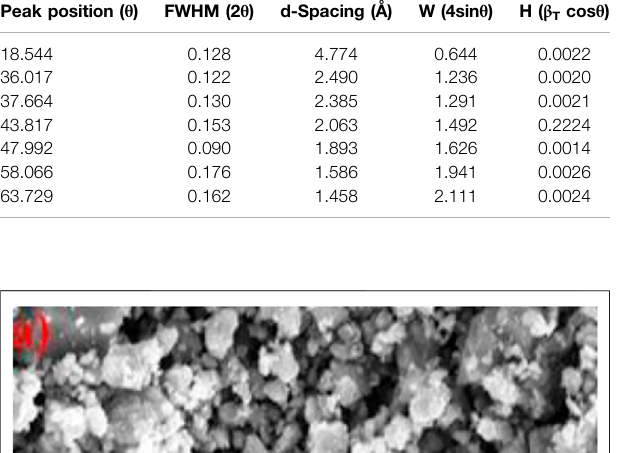
FIGURE1| ThermogravimetricanalysisofthesynthesizedLMOsample.